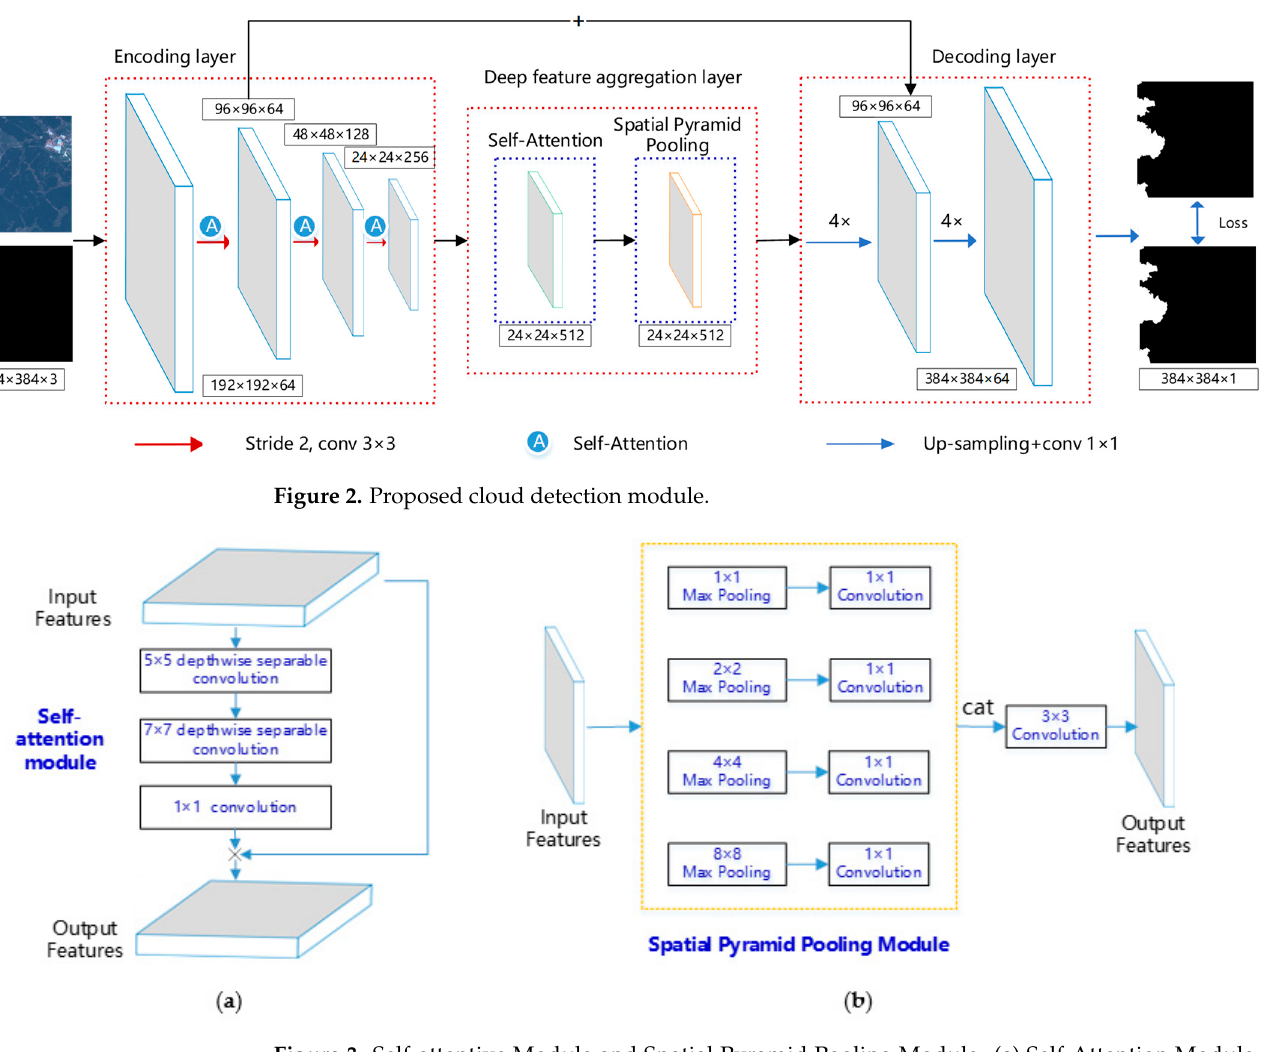
Figure 3. Self-attentive Module and Spatial Pyramid Pooling Module. ( a ) Self-Attention Module. ( b ) Spatial Pyramid Pooling Module.